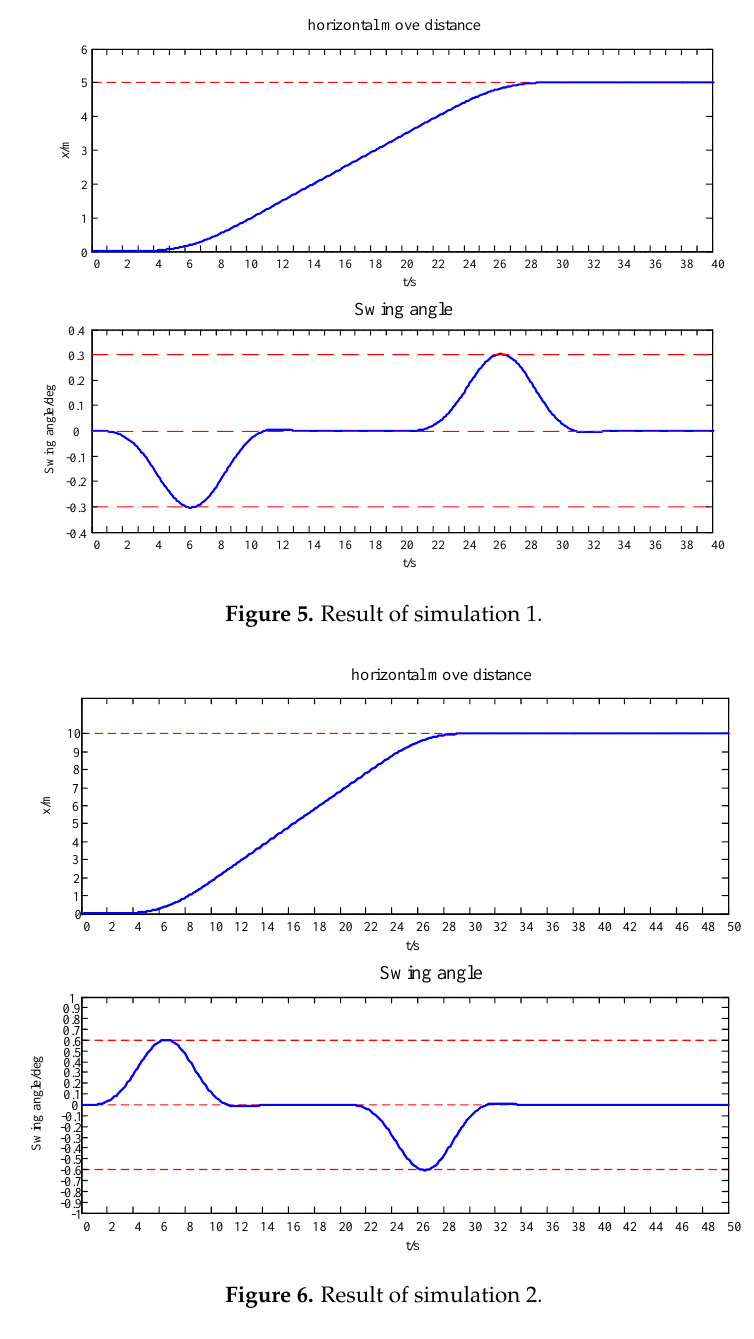
Figure 6. Result of simulation 2.